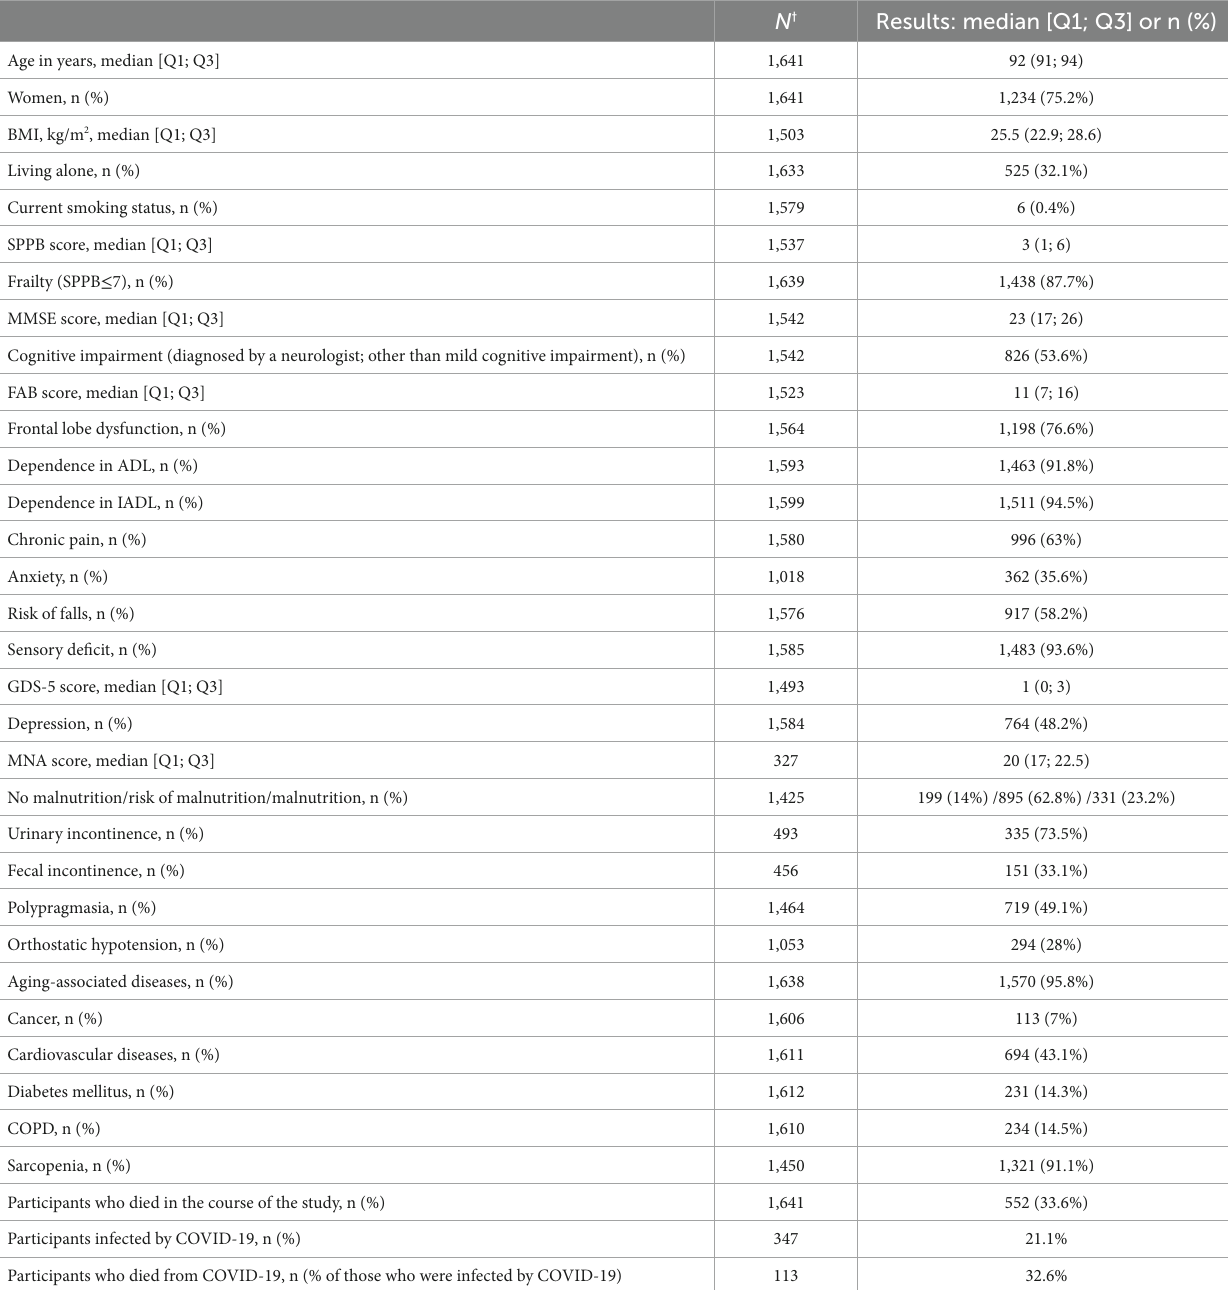
TABLE 2 Baseline participant